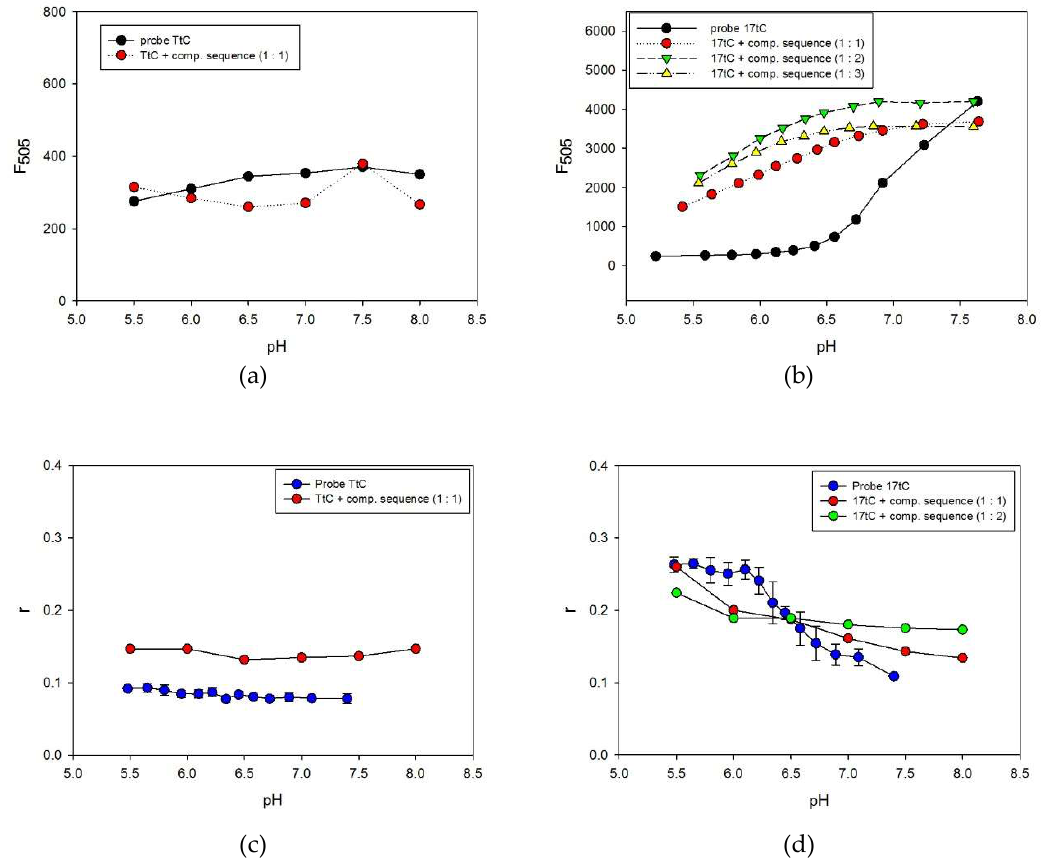
Figure 5. The dependence of fluorescence intensity at 505 nm vs. pH for: TtC ( a ) and 17tC ( b ) probes alone or with their complementary strand. Panels ( c ) and ( d ) show the dependences of fluorescence anisotropy vs. pH for TtC and 17tC, respectively, alone or with complementary strand.